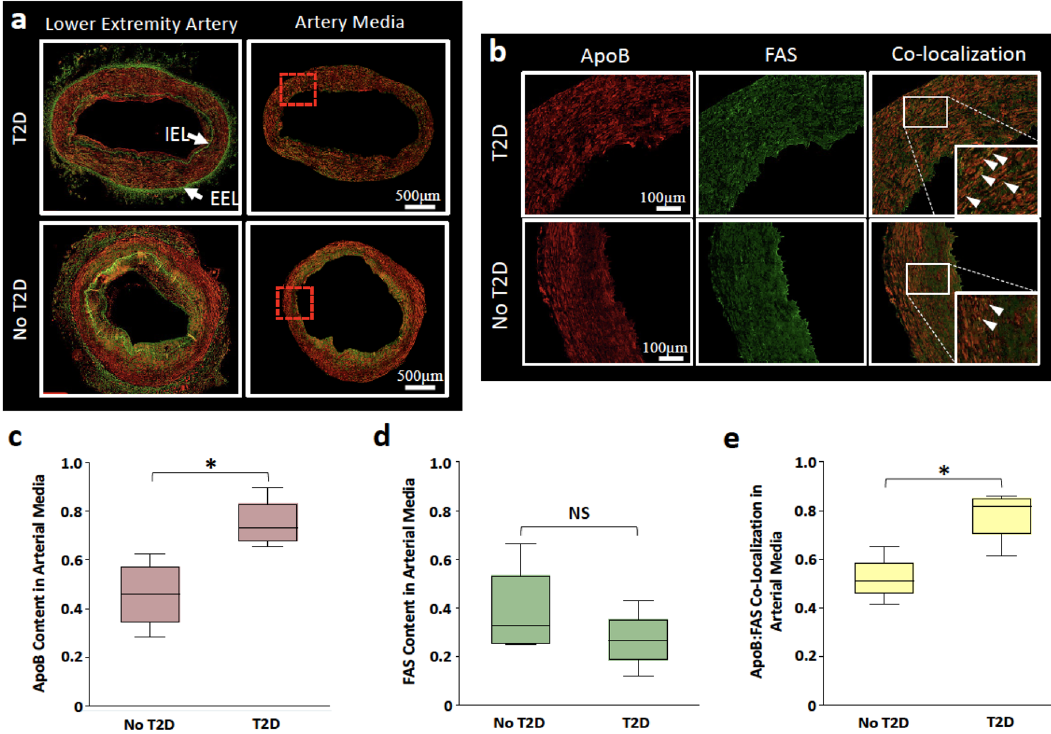
Figure 4. Immunofluorescent staining of FAS and ApoB in lower extremity arterial segments of CLTI patients. Representative lower extremity arterial segments from CLTI patients reflecting the group mean trend were selected. FAS (green), ApoB (red), co-localization of FAS with ApoB (yellow). ( a ) Arterial cross- sections demonstrate arterial intima (lumen boundary to end of IEL) and media (between IEL and EEL). ( b ) ×20 magnification shows co-localization signals (white arrows). ( c ) Mann–Whitney U-test demonstrates that patients with T2D have significantly higher ApoB staining in the arterial media ( P = 0.021). ( d ) No difference was observed in FAS staining in arterial media of patients with or without T2D. ( e ) ApoB and FAS staining co-localization was higher in patients with T2D ( P = 0.043). Signals are reported as proportion of total signal type. Boxplot indicates interquartile range (IQR), median (horizontal line within box), and 1.5 IQR of upper quartile (top whisker) and lower quartile (bottom whisker). NS: Not significant. * P < 0.05. IEL: Internal elastic lamina. EEL: External elastic